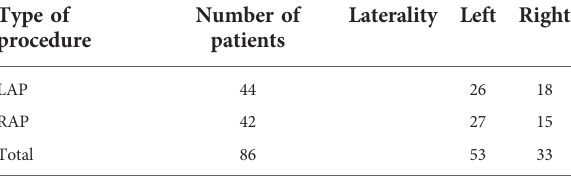
TABLE 1 Patient